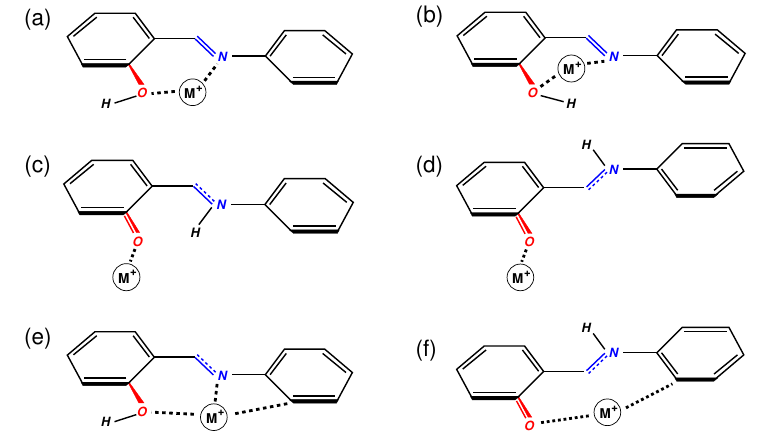
Figure 5. Optimized geometries of complex C: ( a ) enol SA tautomer with the Li + and Na + ions; ( b ) enol SA tautomer with K + ion; ( c ) cis-keto SA tautomer with the ions; ( d ) trans-keto SA tautomer with the ions; ( e ) enol SA tautomer with Zn 2+ ion; and ( f ) trans-keto SA tautomer with Zn 2+ ion ( ω B97X-D